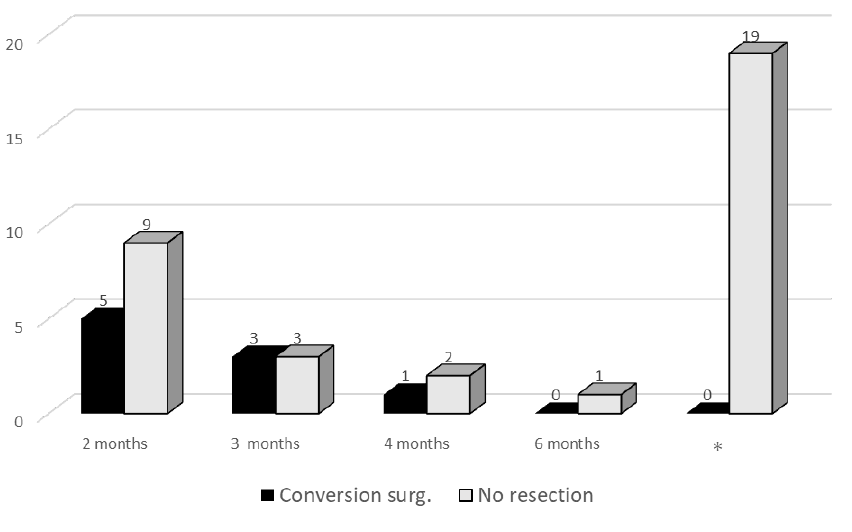
Figure 6. Time of peritoneal cytology becoming negative. Peritoneal washing cytology specimens were examined in i.p.-PTX group patients who had a peritoneal access port. Patients were catego- rized into five groups based on the time of pe ritoneal cytology becoming negative (<2 months, ≥2 months to <3 months, ≥3 months to <4 months, ≥4 months to <6 months, and peritoneal cytology positive).